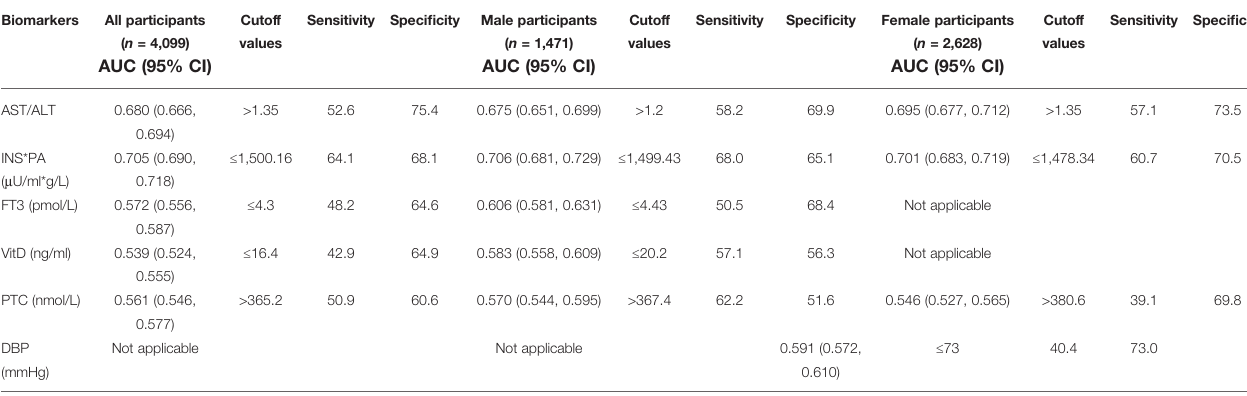
TABLE 4 | The results of ROC analysis of various biomarkers for the diagnosis of sarcopenia. Biomarkers